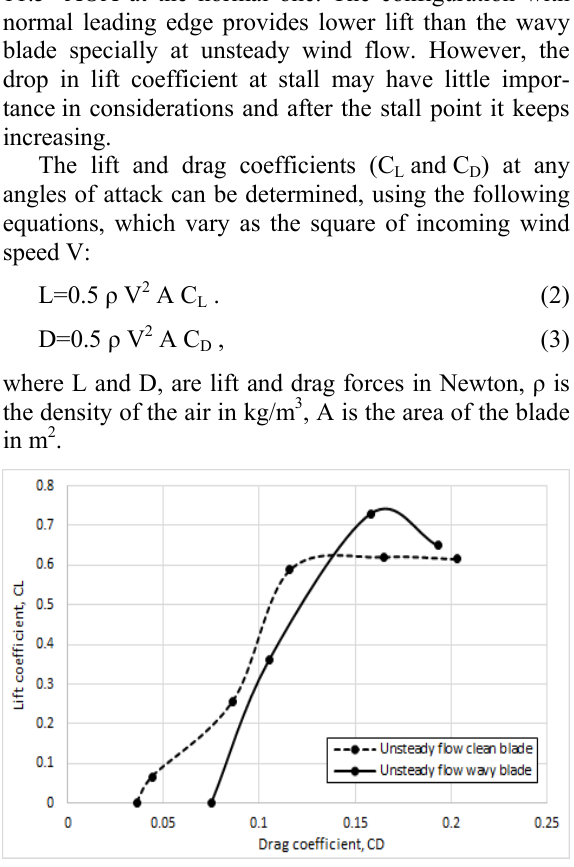
Figure 8. The aerodynamic characteristics of both blades at unsteady flow conditions.